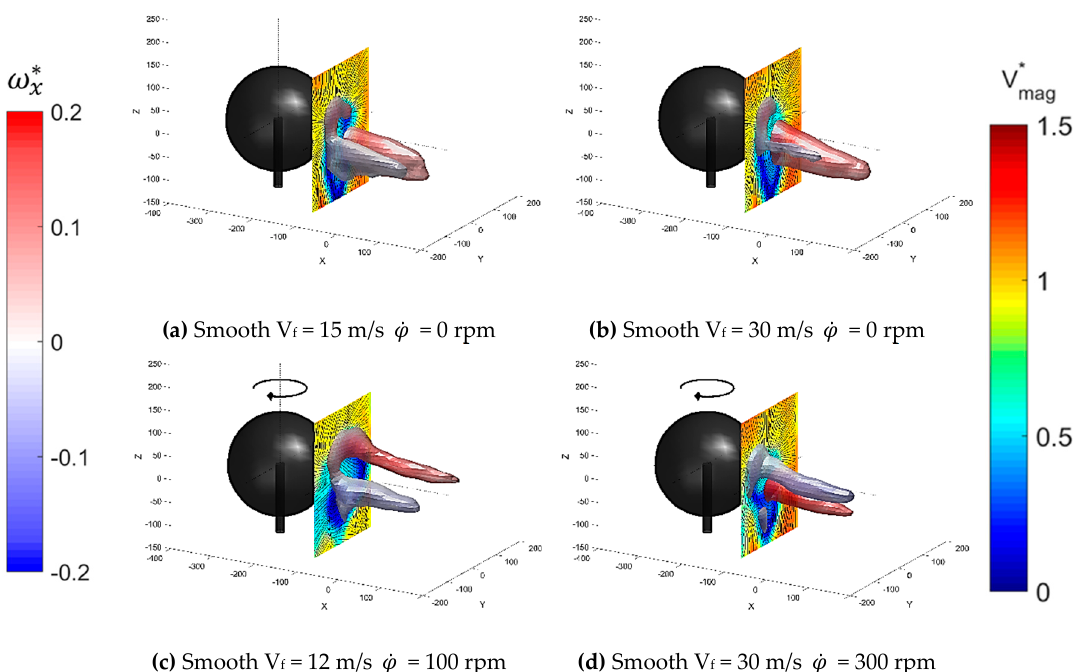
Figure 3. Tomographic PIV data for a range of conditions with the smooth ball. The isosurface is based on λ 2 * and coloured by ω x *. The plane is placed at r/2 behind the ball and coloured by V mag